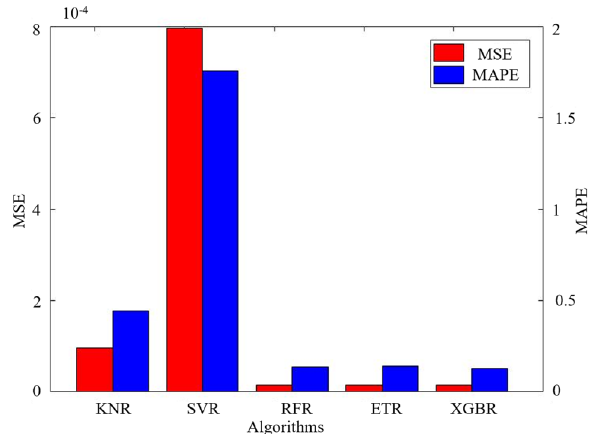
Fig. 10 Evaluation criteria of different